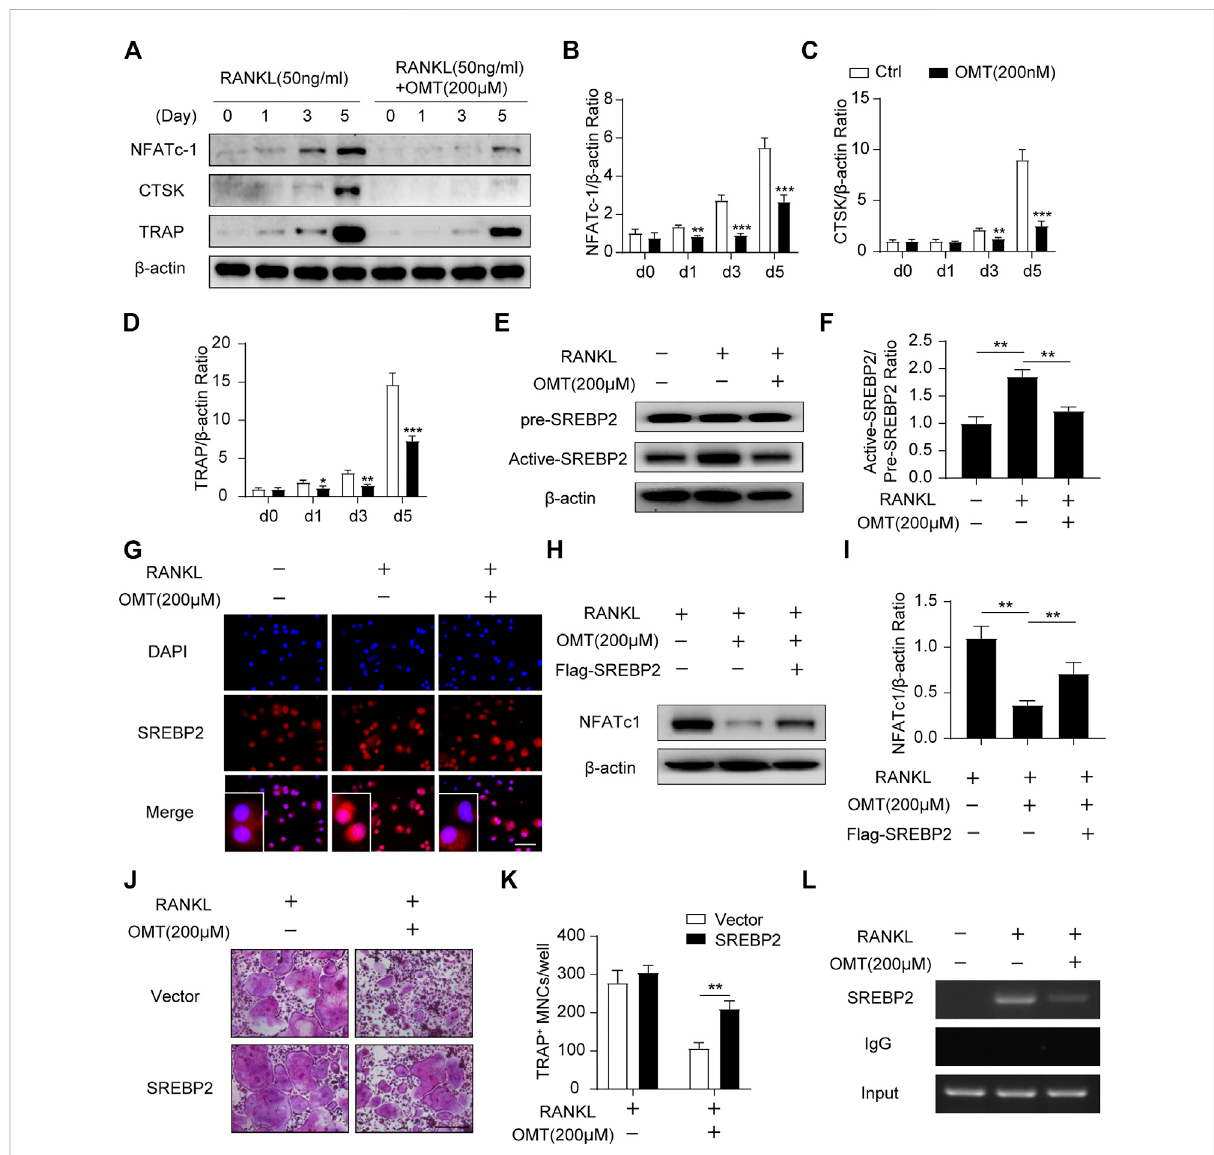
OMTattenuatesSREBP2activityanddownstreamNFATc1expressionduringosteoclastogenesis. (A) BMMswerestimulatedwithRANKL,withor without 200 µM OMT for 0, 1, 3, 5 days, the expression of NFATc1, CTSK and TRAP was tested by western blots. (B – D) Quanti fi cation of the ratios of band intensity of NFATc1, TRAP, and CTSK relative to β -actin ( n = 3 per group). (E) BMMs were treated with RANKL and 200 µM OMT as indicated, western blot was used to detect the level of pre-SREBP2 and active-SREBP2. (F) Quanti fi cation of active-SREBP2/pre-SREBP2 ratio ( n = 3 per group). (G) RAW264.7 cells were treated with RANKL and OMT as indicated, immuno fl uorescence assay was performed to detect SREBP2 translocation. Scale bar = 100 µm. (H) BMMs were transfected with Flag-SREBP2 plasmid or empty vector, then treated with RANKL and OMT as indicated, the expression of NFATc1 was examined. (I) Quanti fi cation of NFATc1/ β -actin ratio (n = 3 per group). (J) BMMs were transfected with Flag-SREBP2 plasmid or empty vector, then treated with RANKL and OMT as indicated. Representative images of TRAP staining were shown. Scalebar=200 µm. (K) Quanti fi cationofTRAP-positivemultinuclearcellsperwell( n =5pergroup). (L) ChIPassaywasperformedonBMMs,treated with RANKL and OMT as indicated. Data were presented as means ± SD. * p < 0.05, ** p < 0.01, *** p <